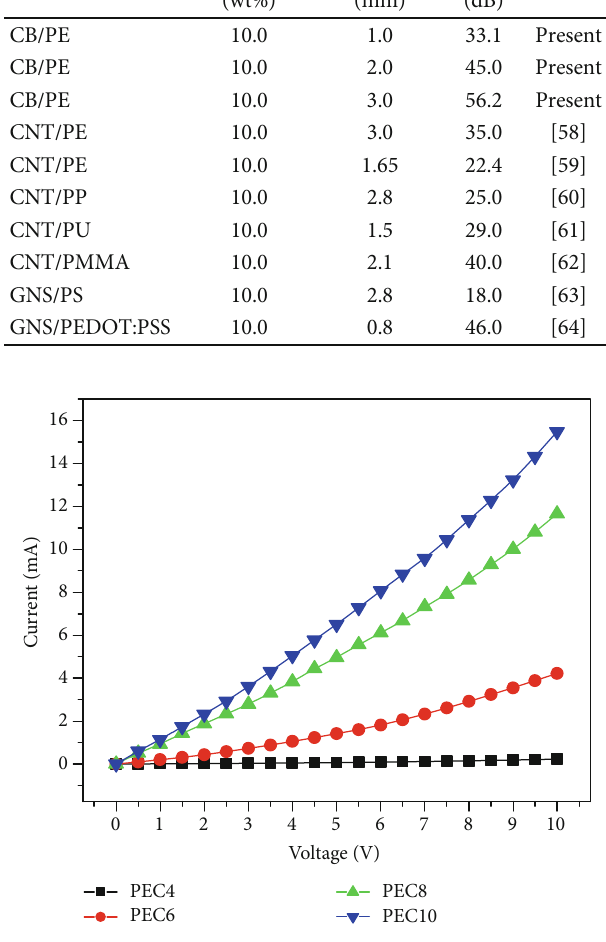
Figure 13: Current-voltage characteristics of selected